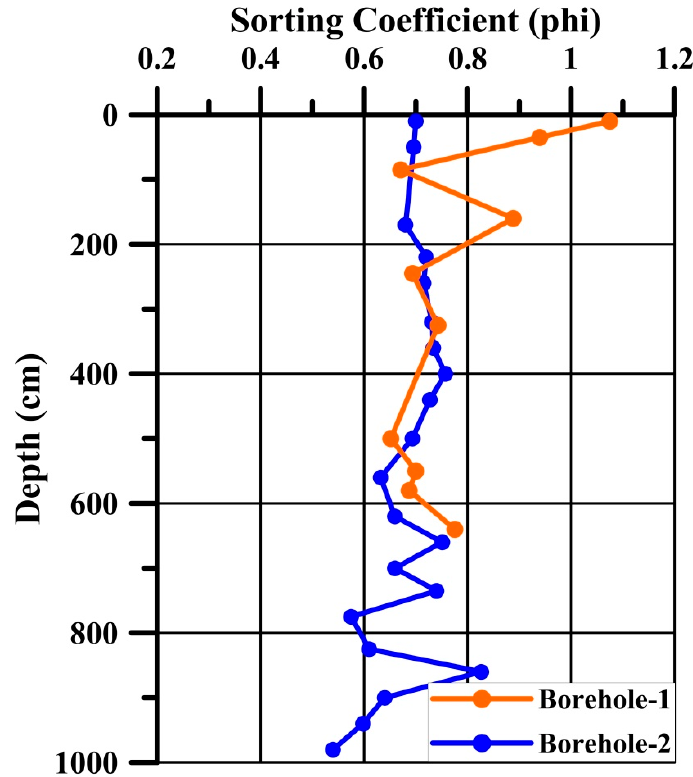
Figure 9. Sand grains sorting profiles of the two boreholes.